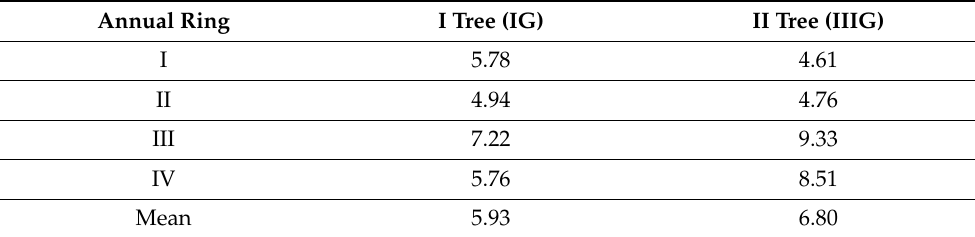
Figure 2. Cross-section of a young Paulownia tree trunk with a marked macroscopic structure. Table 1. Width of the annual rings of the examined Paulownia tree trunks.